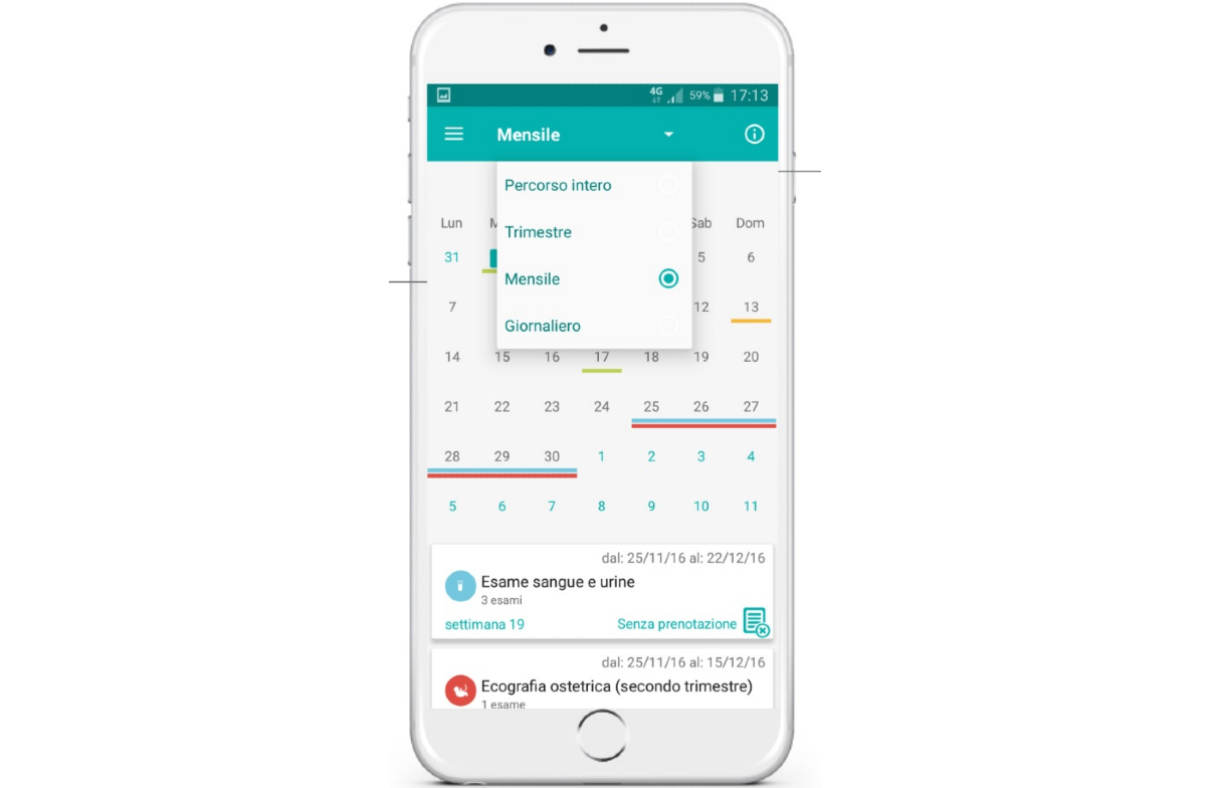
Figure 2. hAPPyMamma agenda: digitization of the pregnancy booklet and infant vaccination calendar in the app planner, with different visualization options and alert